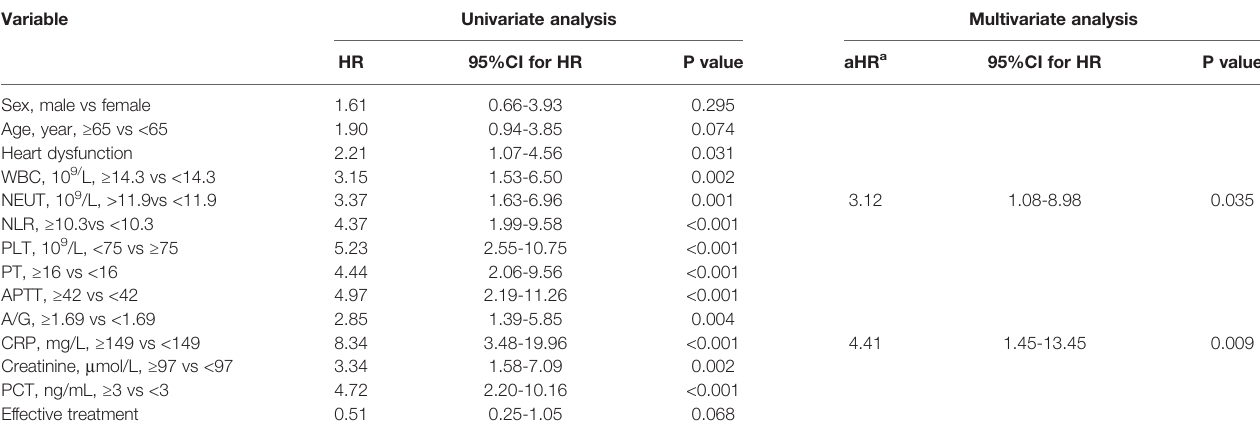
TABLE 3 | Univariate and multivariate Cox regression analysis of risk factors for 30-day mortality. Variable